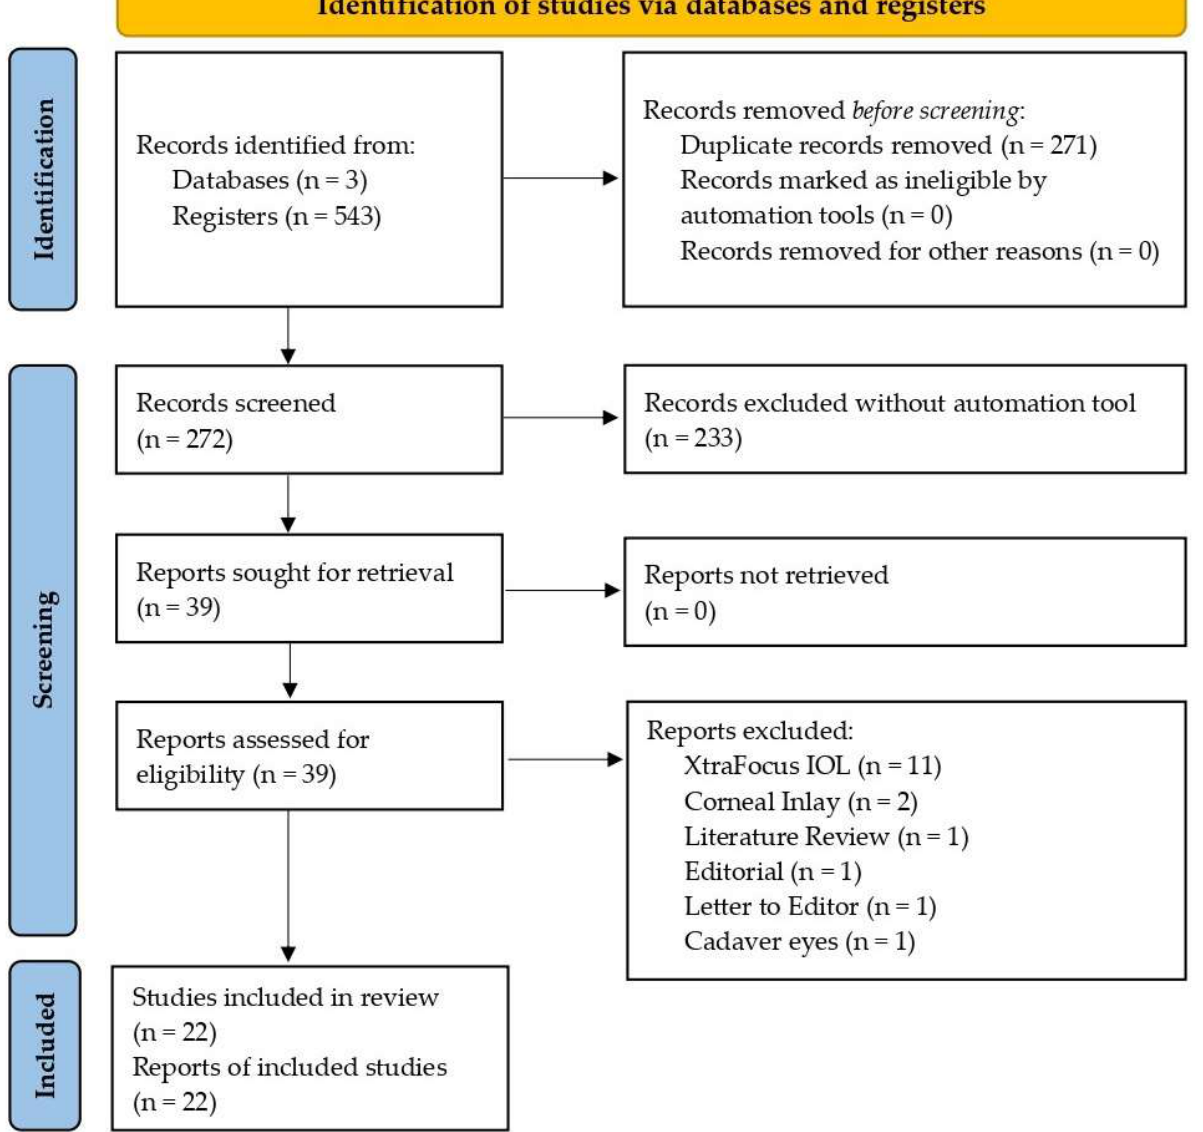
Figure 1. Flowchart study selection process according to the PRISMA statement.